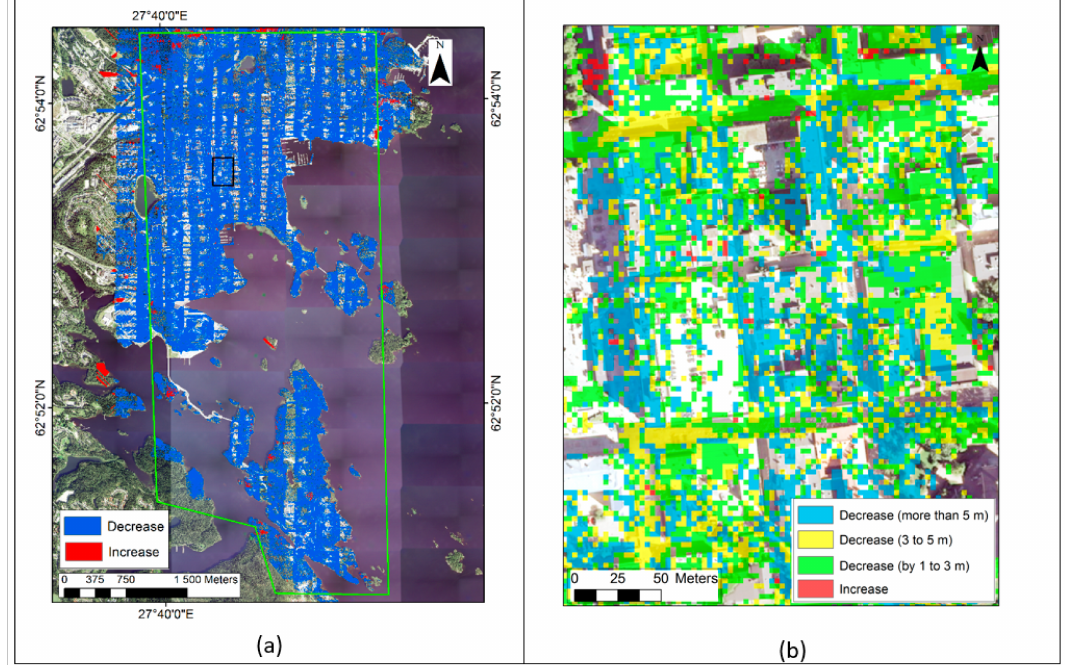
Figure 4. ( a ) Pixels in our study area (demarcated by light green polygon) where the standard deviation changed substantially (more than 1.0 m) after adjustment. We further analyze the area demarcated by the black box (part of downtown Kuopio) in part ( b ). ( b ) Changes in standard deviation over a representative part of the downtown urban area (see black demarcation box in ( a )). The underlying aerial image shows several building blocks from above. Transparent areas denote negligible decease in SD (less than 1.0